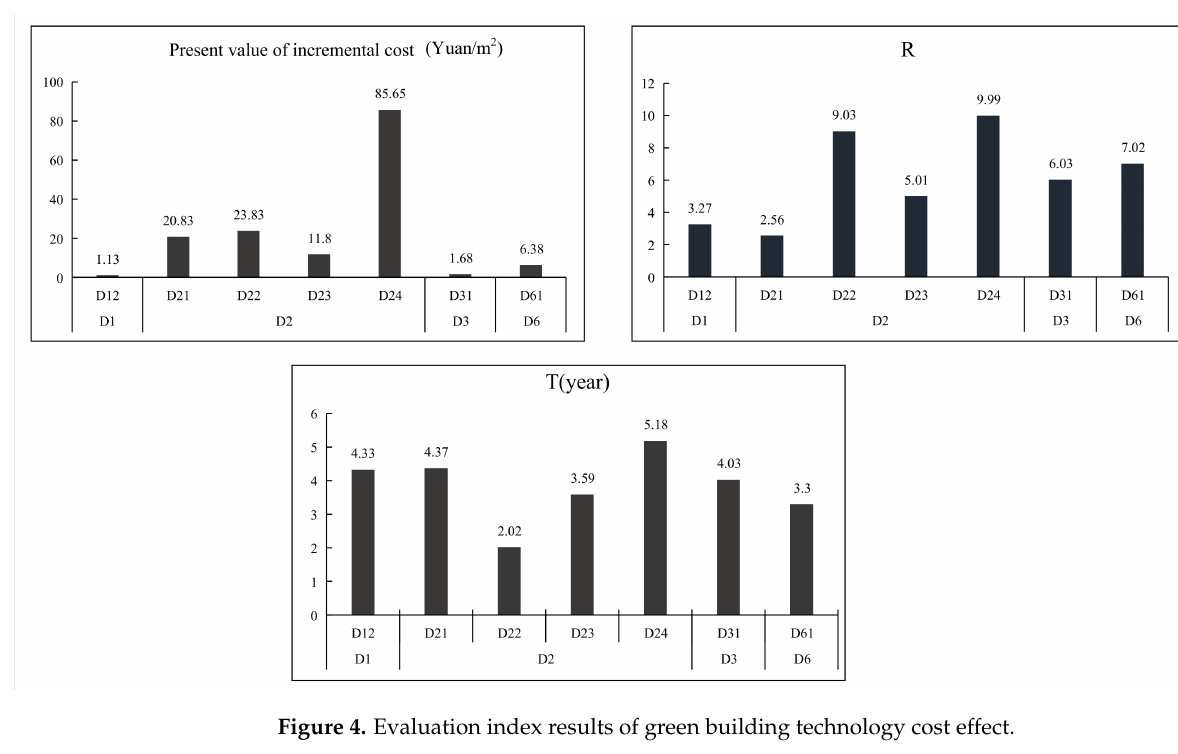
Figure 4. Evaluation index results of green building technology cost effect.